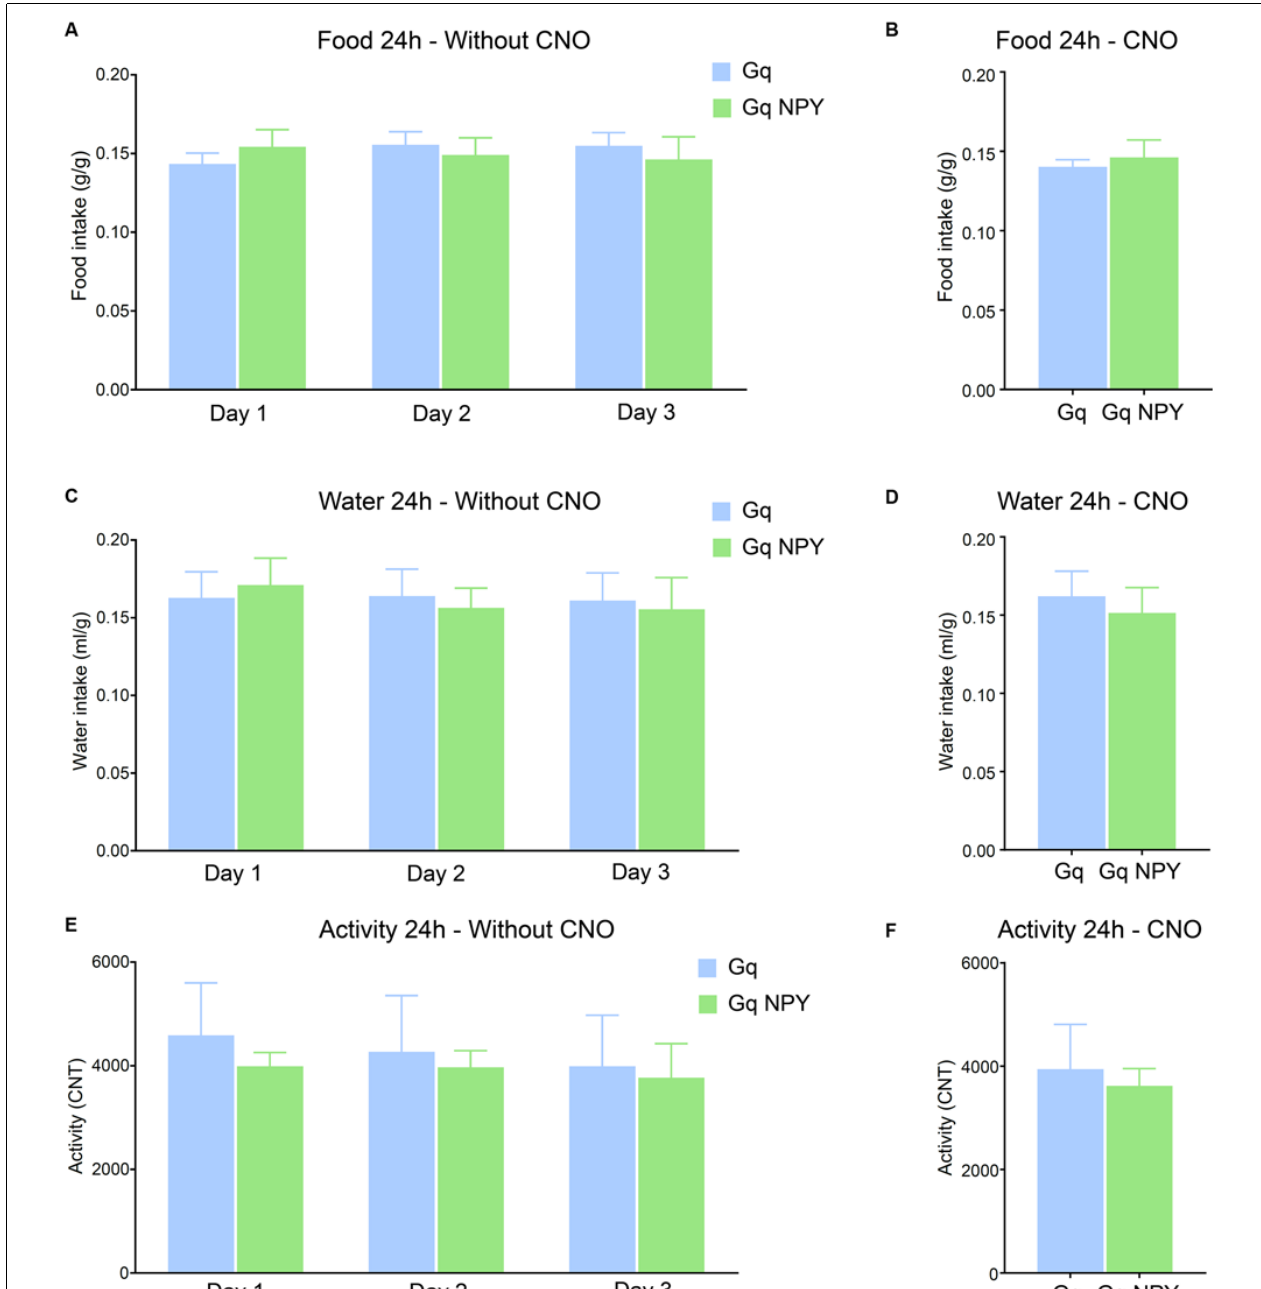
FIGURE 4 | Activation of GABAergic neurons in the dorsal dentate gyrus with or without overexpression of NPY does not alter food intake, water intake, or home cage activity. (A) No difference in cumulative 24 h food intake per body weight (g/g) across three consecutive light/dark cycles. (B) No change in cumulative 24 h food intake per body weight after ip injection of CNO. (C) No difference in cumulative 24 h water intake per body weight (ml/g) on three consecutive days. (D) No change in cumulative 24 h water intake per body weight after ip CNO injection. (E) There was also no difference in cumulative 24 h home cage activity under baseline conditions or (F) after peripheral CNO injection. Gq: n = 4, Gq + NPY: n =